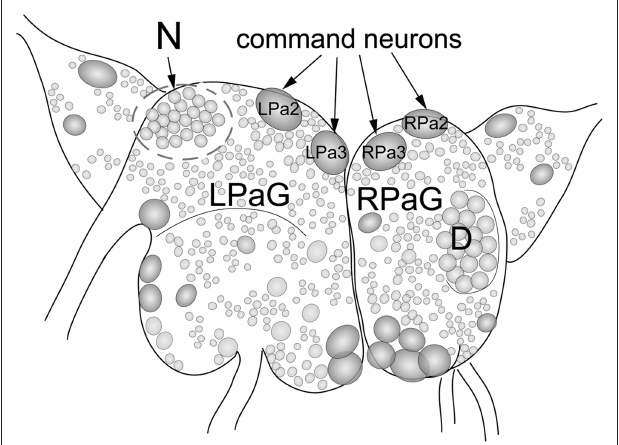
FiguRE 1 | Location of large identified neurons and neuronal clusters in the CNS of Helix lucorum . The figure shows the left and right parietal ganglia (LPaG, RPaG). Numbers designate individual identified neurons: giant neurons (2 and 3) symmetrically located in the left and right parietal ganglia, correspond to the giant interneurons (command neurons) of withdrawal behavior LPa2, LPa3 [LPa(2/3)] and RPa2, RPa3 [RPa(2/3)]. Outline areas indicate the region containing neurons belonging to the D-group and the N-group. Command neurons LPa(2/3), RPa(2/3), and neurons of the D-group were used for